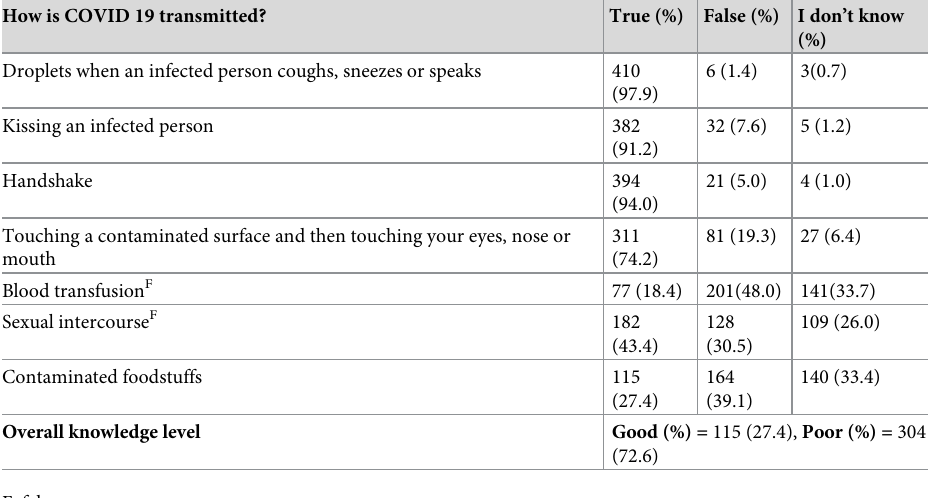
Table 2. The participants’ knowledge towards COVID-19 mode of